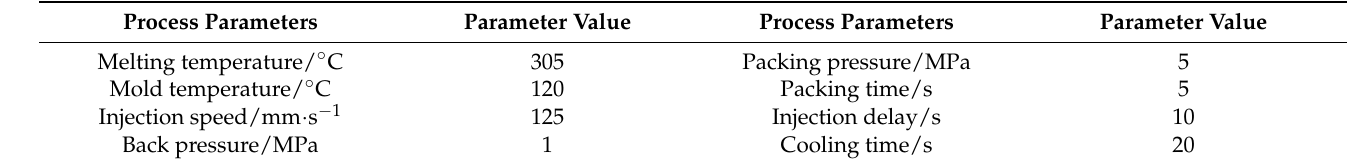
Table 7. Injection process